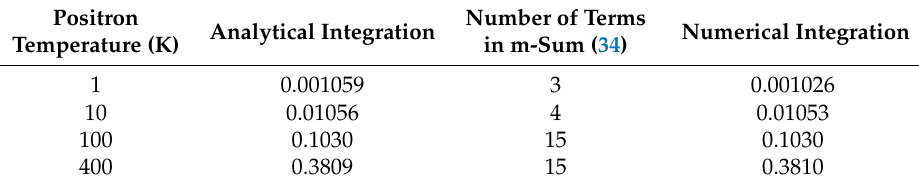
Table 1. The rate coefficient α RA (10 − 15 cm 3 s − 1 ) for attaching a positron to antihydrogen to form H for a fifty-term wave